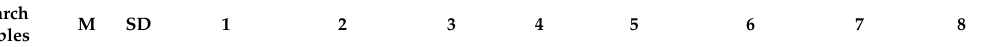
Table 1. Means, standard deviations, and correlations among research